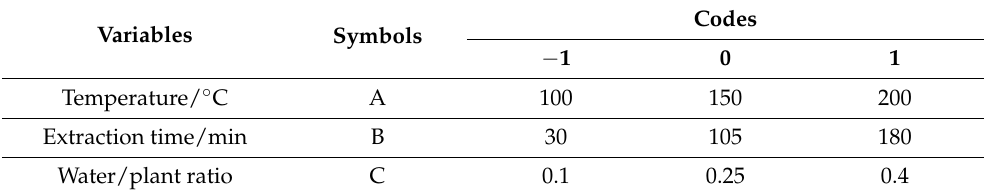
Table 7. Optimization of the subcritical water extraction of O. mutabilis . Variables